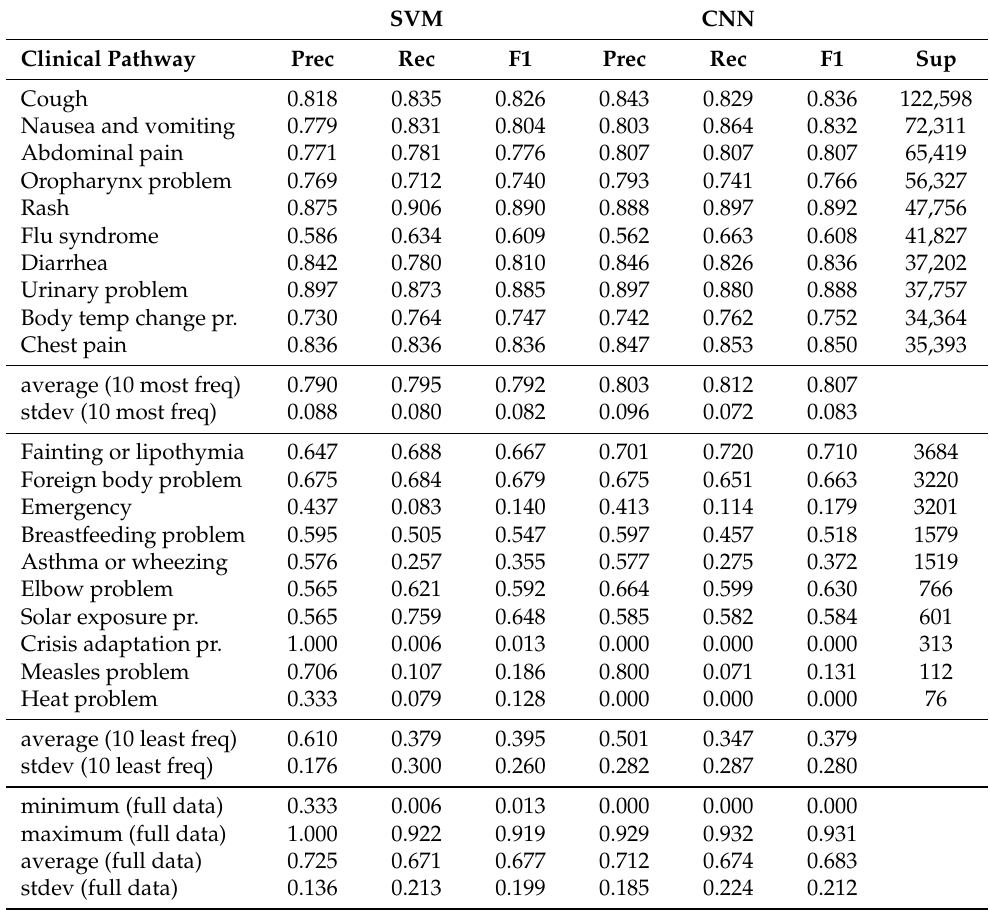
Table 4. Test set precision, recall and F1 of 2017–2018 SVM and CNN models for the 10 most and least frequent